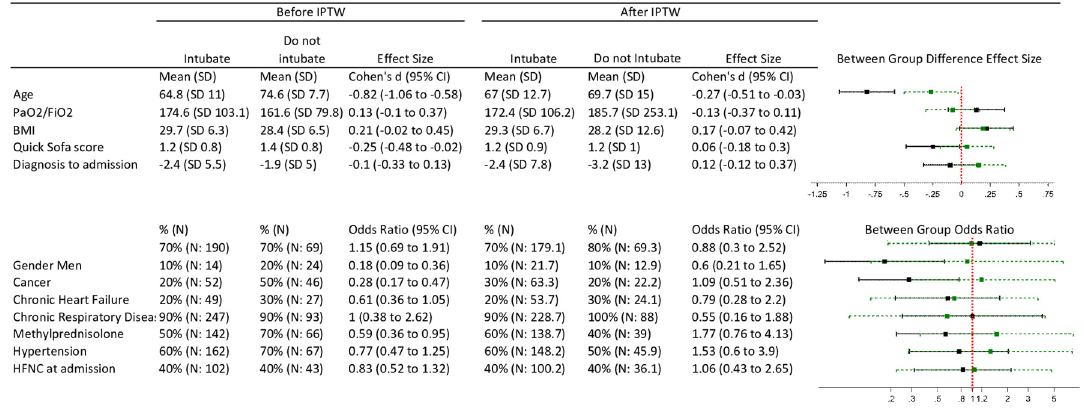
Figure 3. Characteristics of the patients before and after applying inverse probability of treatment weighting. Black Caterpillar plot represents risk ratio to death before inverse probability of treatment weighting. Green caterpillar plot represents risk ratio to death after inverse probability of treatment weighting. BMI: Body Mass Index; HFNC: High Flow Nasal Cannula; IPTW: Inverse Probability of Treatment Weighting; n : Number of patients; SD: Standardized Deviation.